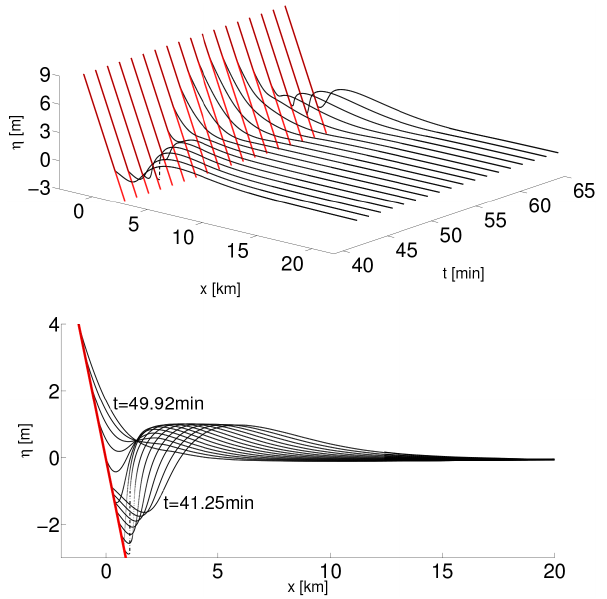
Figure 19. Free-surface profiles of a breaking wave simulation for the linear model coupled to the NSWE (dashed and dotted-dashed lines) and for the linear model with an EBC implementation (solid line) at t = 40–70min. The solid and dashed lines are on top of one